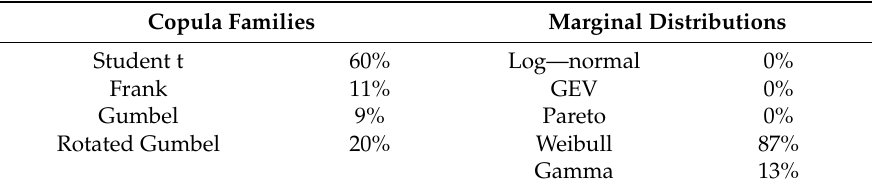
Figure 4. The AIC values for a random grid. Table 3. The percentiles of the selected copula families and marginal distributions.